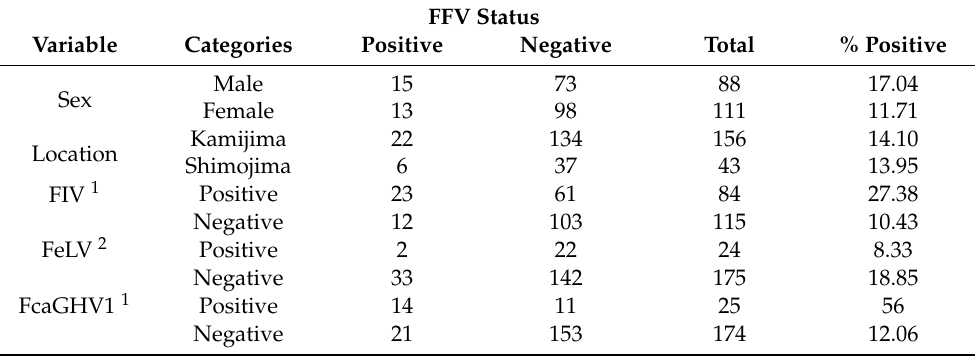
Table 3. Prevalence of FFV among domestic cat samples.